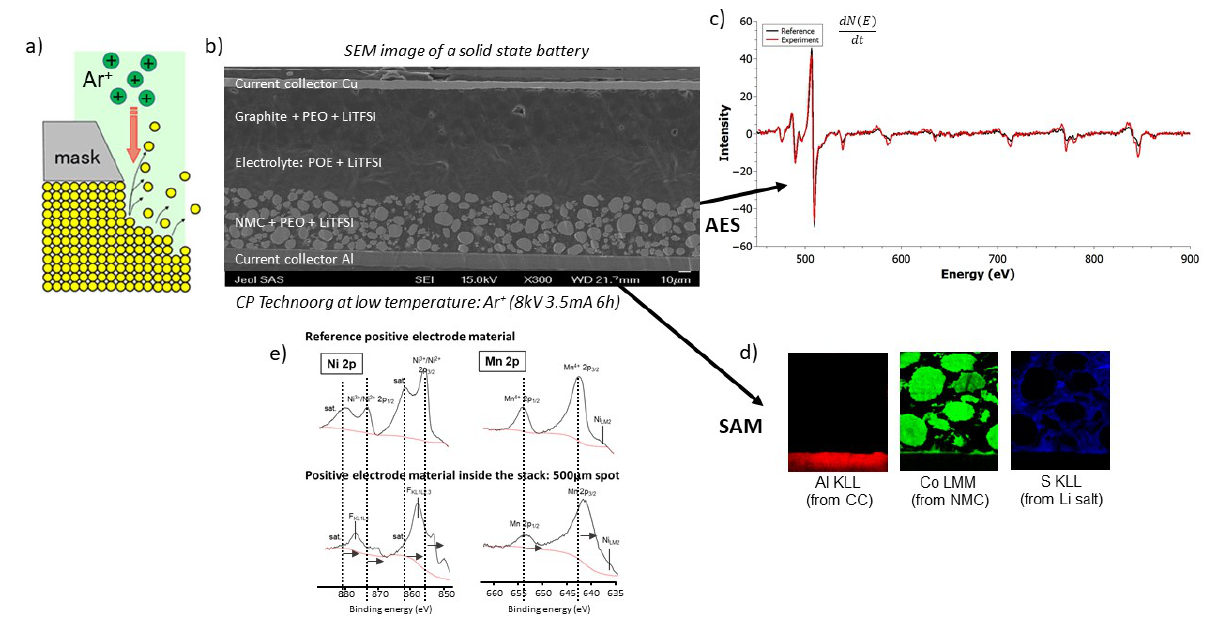
Fig. 2. a) Schematic representation of the ion milling ( i.e. cross-polishing) principle, b) SEM image of a NMC/PEO-LiTFSI/graphite cross-section obtained after 6h at 8 kV, 3.5 mA and 133°K, c) comparison of AES spectra for the reference NMC electrode and the cross-section, d) SAM (elemental 2D nano distribution) images of the cross-section, e) comparison between XPS spectra from